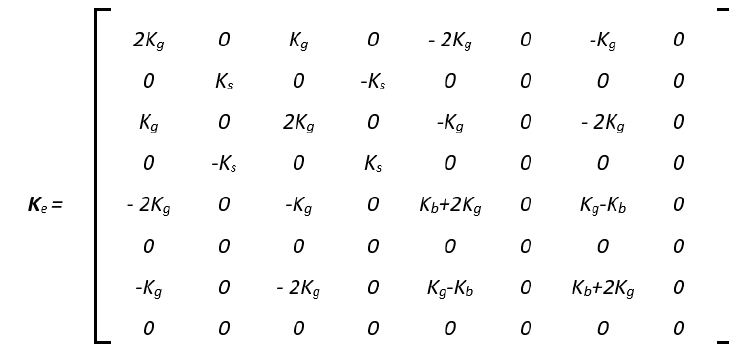
Figure 3. The stiffness matrix of the element